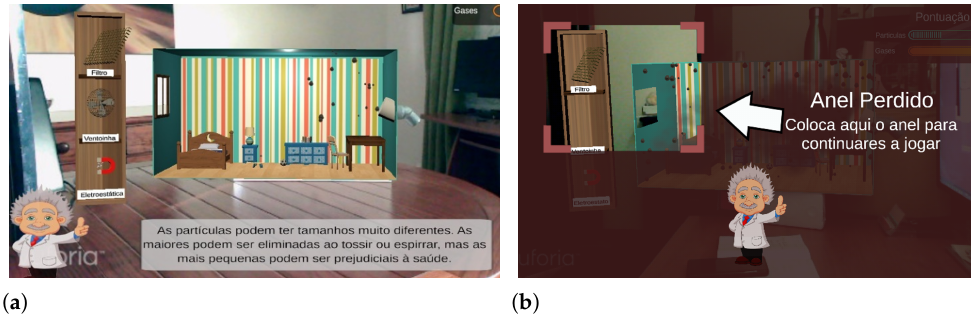
Figure 10. Interaction with the NPC. ( a ) A screenshot of the game with the scientist NPC and its subtitles (in Portuguese) at the bottom. Subtitles translation: Particles can have very different sizes. The larger ones can be expelled by coughing or breathing, but the smaller ones can be harmful to our health. ( b ) Assistance screen shown when the ring marker is lost. Overlaid text translation: Ring lost. Place the ring here to continue playing